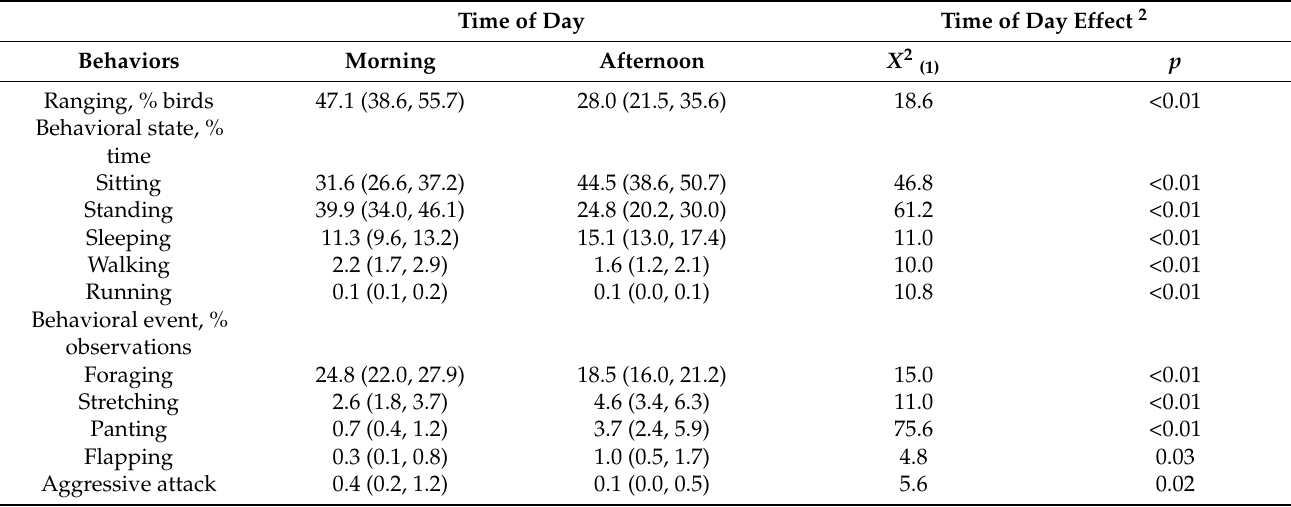
Table 5. Means ± 95% CI of behaviors affected by time of day for mixed-sex Freedom Ranger chickens raised in a free-range system from 5 to 11 weeks of age 1